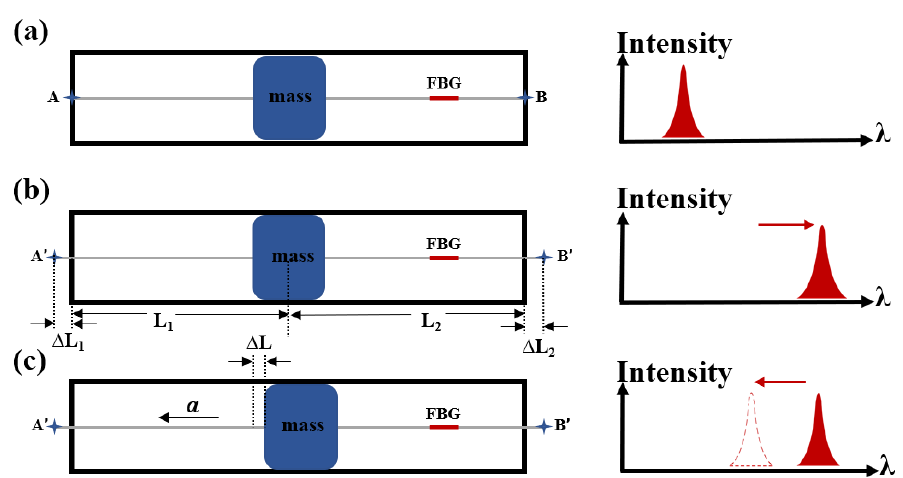
Figure 2. Schematic illustration of the principle. ( a ) Before pre-stretching; ( b ) wavelength drift magnification; ( c ) under axial acceleration a.